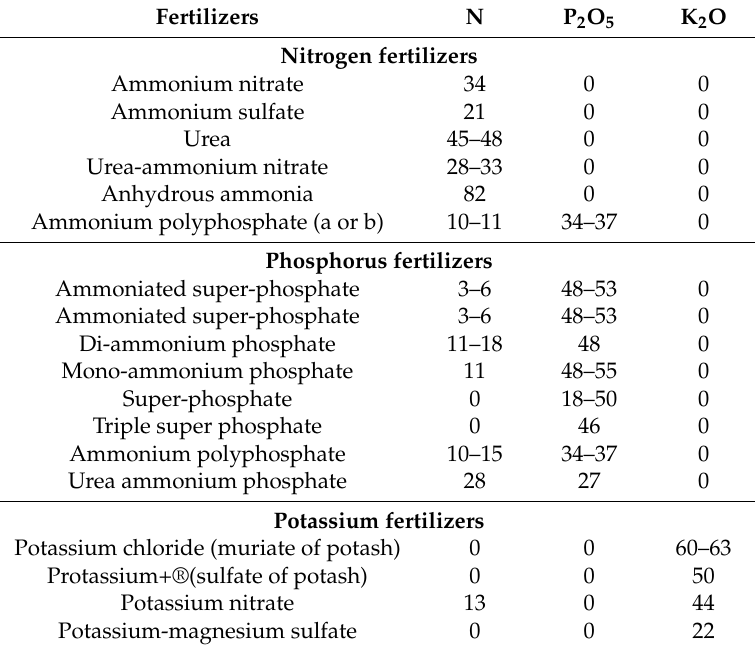
Table 1. Some macronutrients fertilizers and their composition Data from